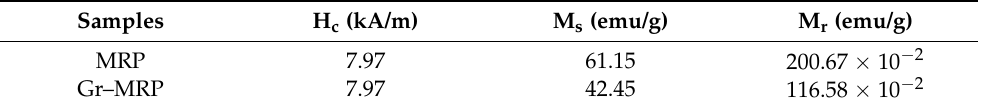
Figure 5. Magnetization curves of MRP and Gr–MRP samples. Table 2. Magnetic properties of MRP and Gr–MRP